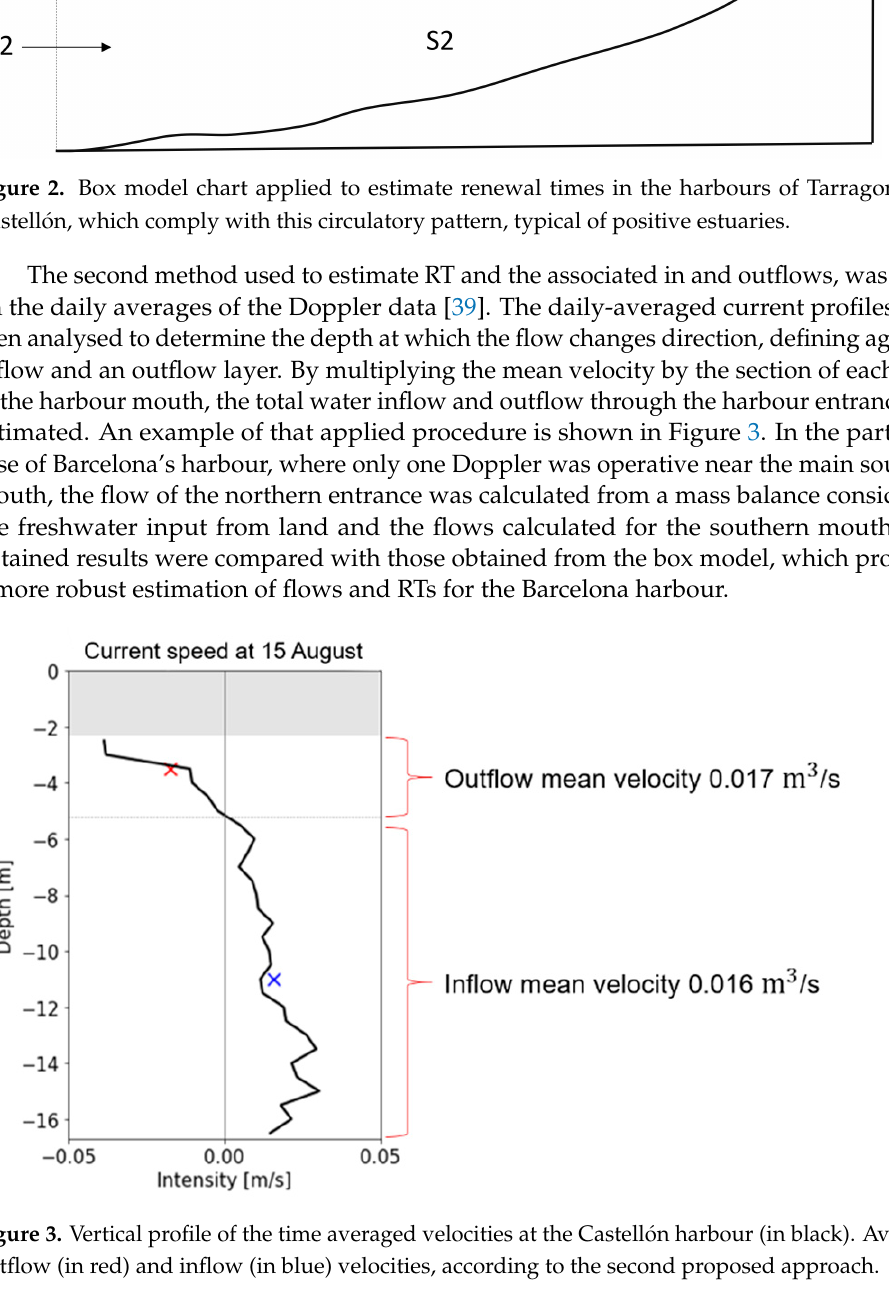
(e.g., approximate mouth section areas, and uniform and stationary flows at the mouth) introduced further uncertainties to the estimated flow rates and renewal times. Because of this, the results presented must be considered as an approximation to the real behaviour of the harbour system. 3. Results Any application of harbour circulation results to the integrated management of port activities requires a robust knowledge of the relation between meteocean forcings and harbour hydrodynamic responses, which include the renovation times, the domains af- fected, the trajectories, and the cumulative concentrations. Figure 4 presents the simulta- neous evolution of meteocean drivers, together with harbour circulation responses in a single plot. The upper time series in Error! Reference source not found. presents the wind rec- orded at weather station number two in each harbour. The series has significant similari- ties regarding the strongest and weakest meteo events. The corresponding wind roses are shown in Figure 5. In the Barcelona harbour (Figure 5a), the prevailing winds during the campaign came from the south and west, although the most energetic were mainly from the north-east and the south-west, with the maximum intensities, in general, approxi- mately 10 m/s. In Tarragona (Figure 5b), the prevalent winds throughout the campaign blew from the north and the south-east, while the strongest winds were from the south- west, with maximum speeds of 11 m/s. Regarding the Castellón harbour (Figure 5c), the most frequent winds were those from the north-west, while the strongest winds came from the north-east, typically with speeds between 9 and 13 m/s. Because of the local topographic control over the wind fields there were marked dis- crepancies in wind direction among the three harbours. However, the main wind direc- tional sectors were north-east and south-west in all three cases during the most extreme wind events.